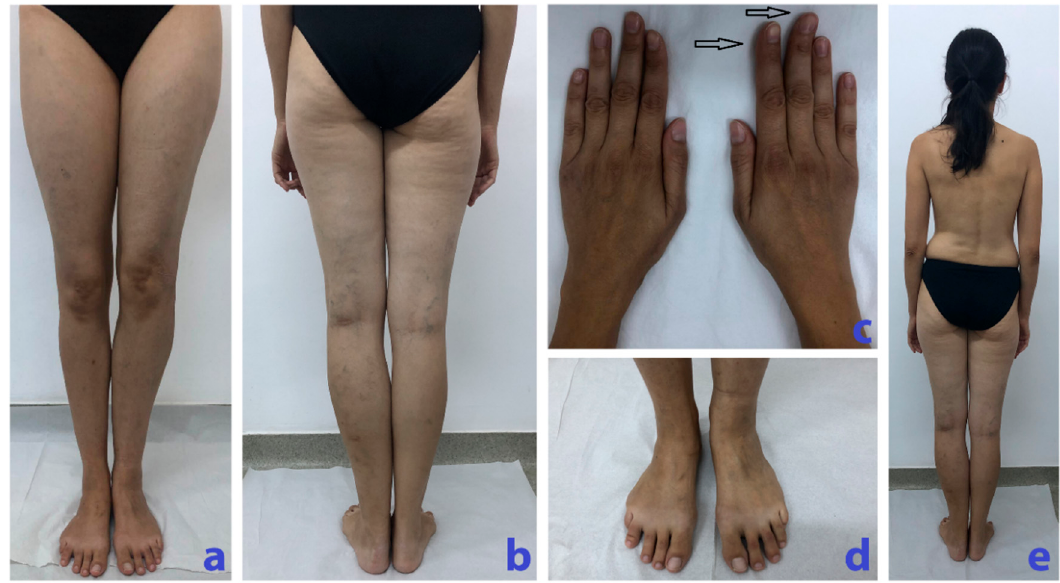
Figure 1. ( a ) Longer left calf with slight deformity. ( b ) Longer and larger left calf with vascular ectasias. ( c ) Hands with discrete enlargement and ax deviation of the 2nd and 3rd right fingers with macrodactyly (arrows). ( d ) Larger triangular right foot with a “sandal gap” between the 3rd and the 4th toes. ( e ) Scoliosis, longer and larger left calf.